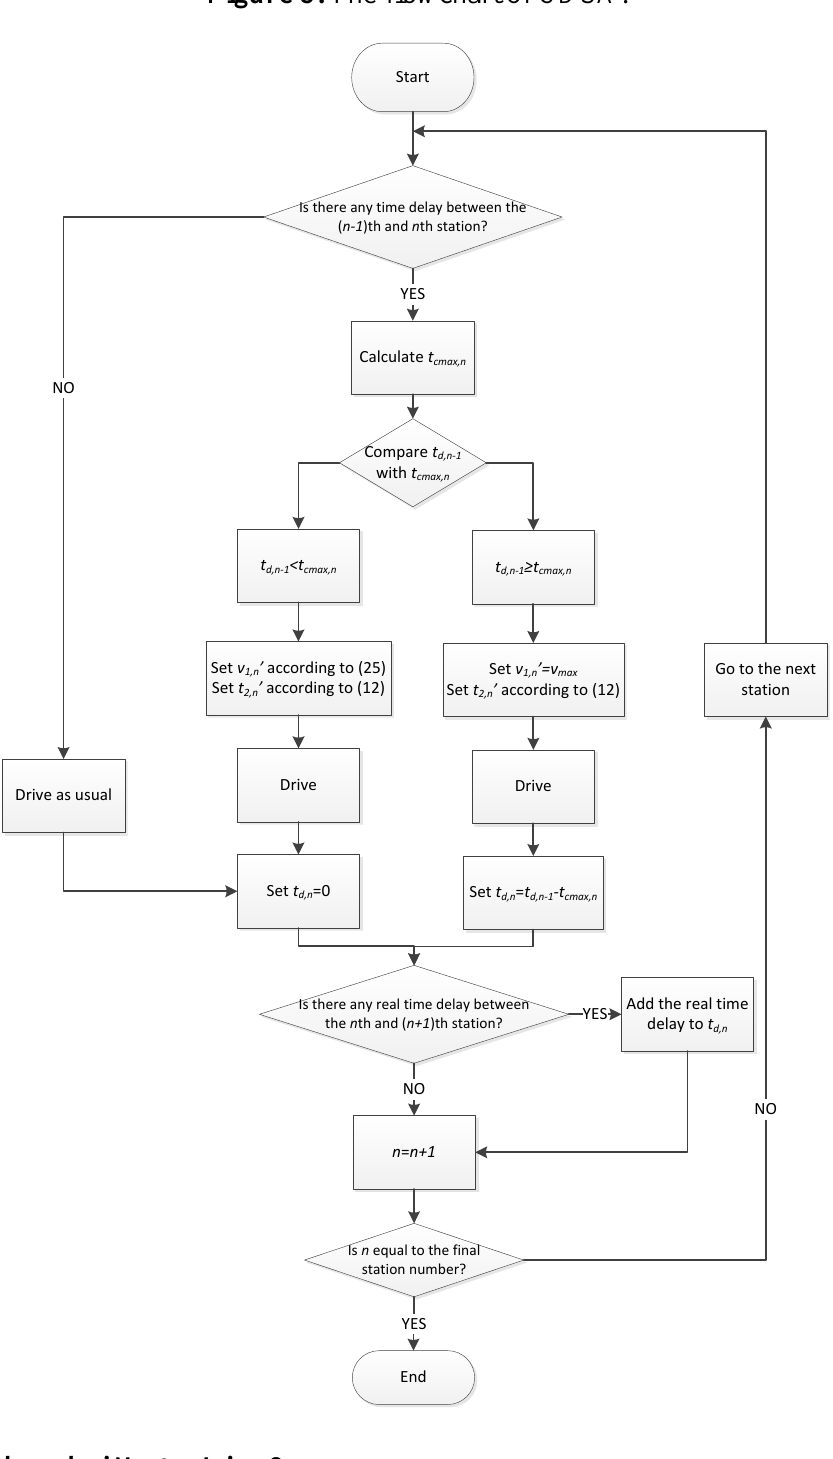
Figure 5. The flowchart of